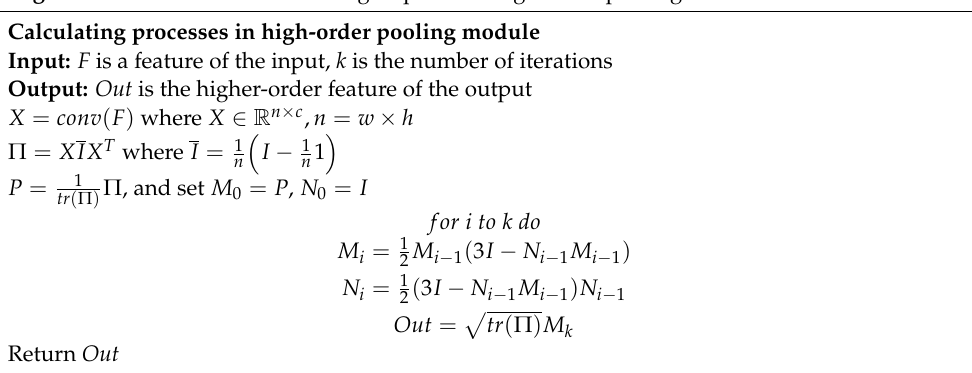
Algorithm 1. The overall calculating steps of the high-order pooling module. Calculating processes in high-order pooling